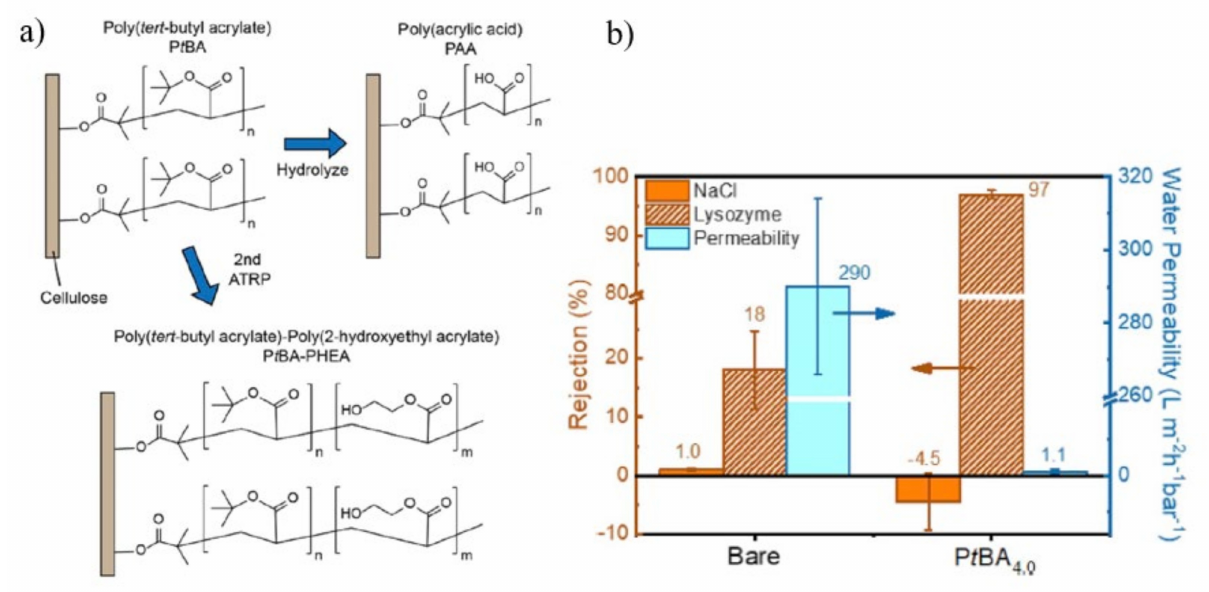
Figure 6. ( a ) Structure of polymer brush chains; ( b ) Permeability and rejection of pristine and modified membrane